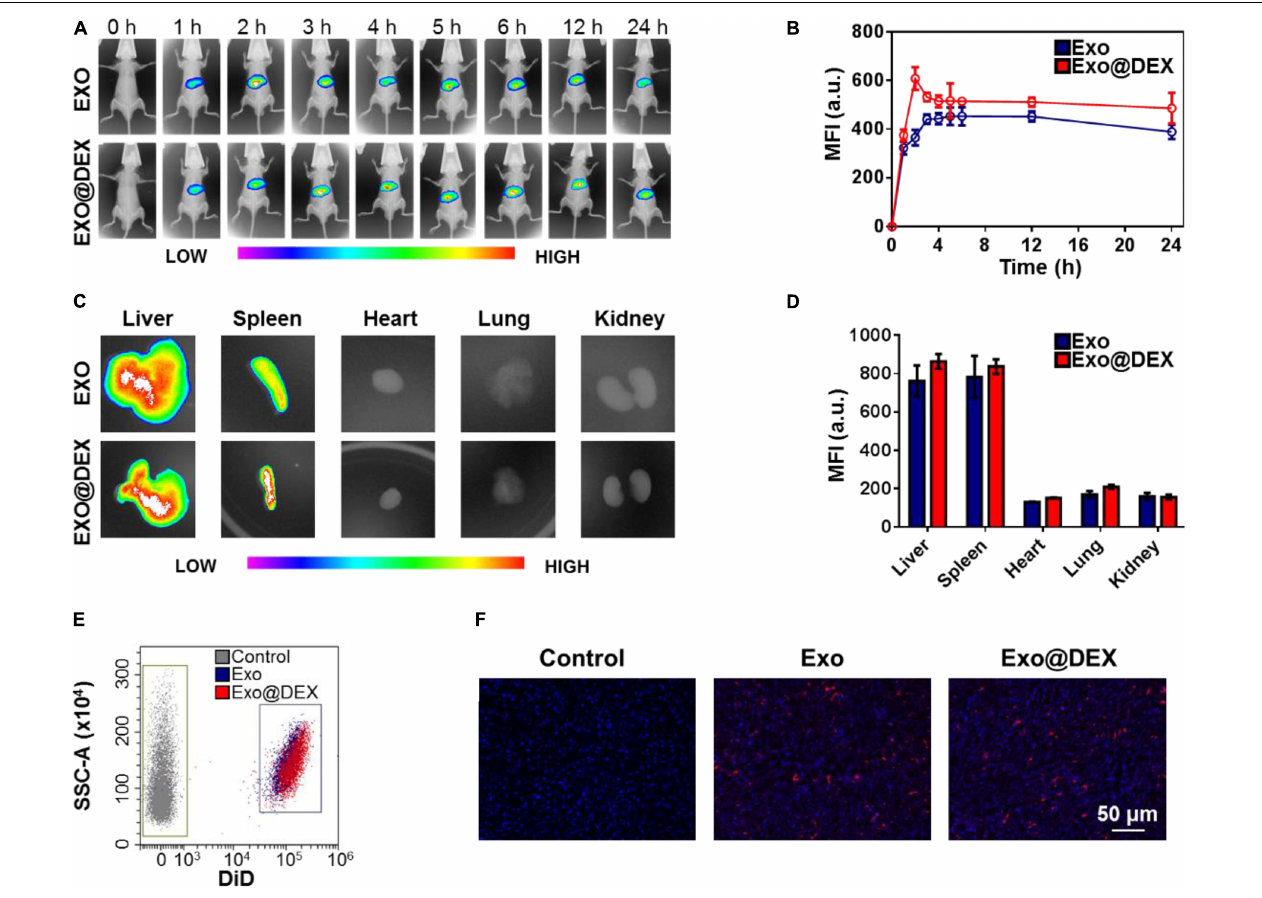
FIGURE 3 | Biodistribution of Exo@DEX in vivo and ex vivo . (A) In vivo fluorescence signal of mice treated intravenously with DiR-labeled Exo or Exo@DEX and imaged 1, 2, 3, 4, 5, 6, 12, and 24 h after the treatment. (B) Quantitative analysis of in vivo imaging. (C) Ex vivo fluorescence signal of collected organs from mice sacrificed 2 h after treatment. (D) Quantitative analysis of ex vivo imaging. (E) Flow cytometry analysis of homogenated liver tissues after DiD-labeled Exo or Exo@DEX treatment. (F) Liver tissues excised 2 h after treatment with DiD-labeled Exo@DEX or PBS, stained with DAPI, and visualized by confocal